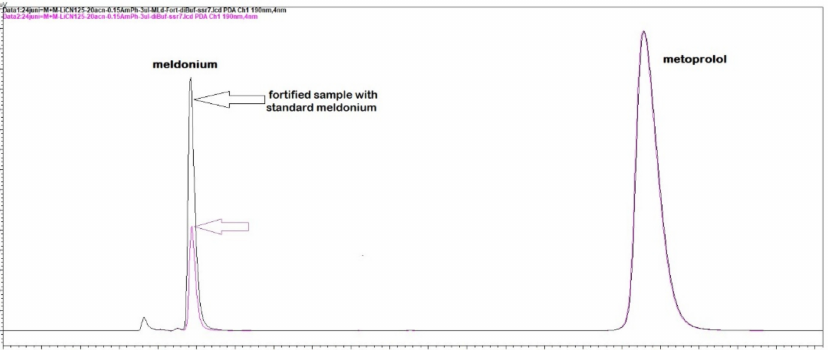
Figure 1. LiChrospher 100 CN column 125 × 4 mm, 2-wavelength comparison chromatogram, worked out with 20% ACN and 80% 12 mM (0.15% s / w ) NH 4 H 2 PO 4 (Shimadzu LC-40).